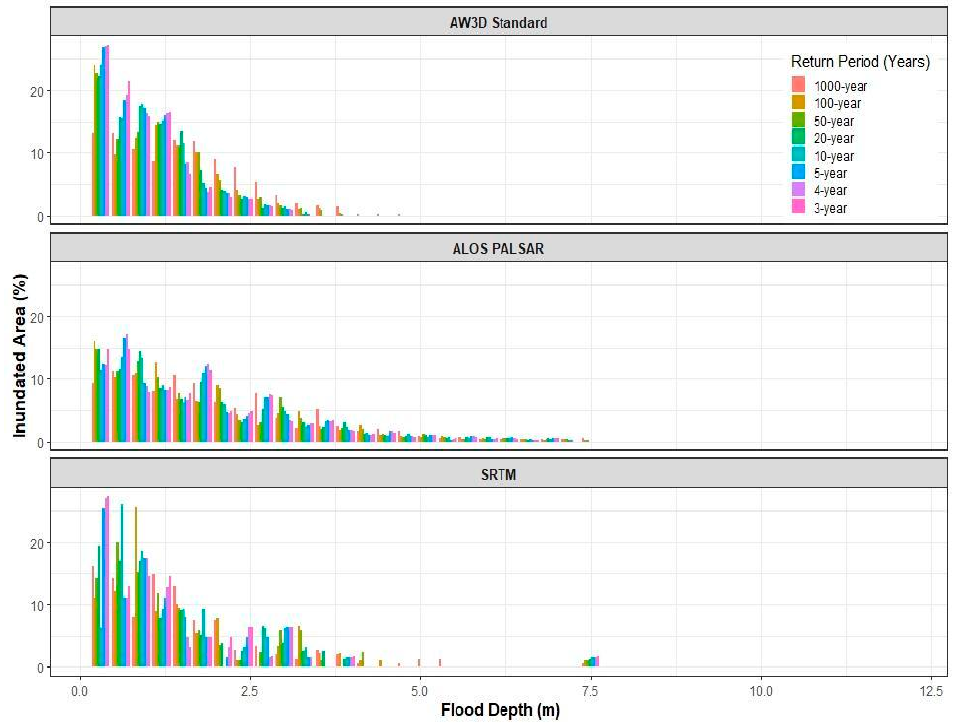
Figure 5. Distribution of flood depths across the floodplain areas of AW3D Standard, ALOS PALSAR and SRTM. Results from all flood events are shown. The y -axis is the percentage of inundation area over the total inundation area for each considered flood depth.